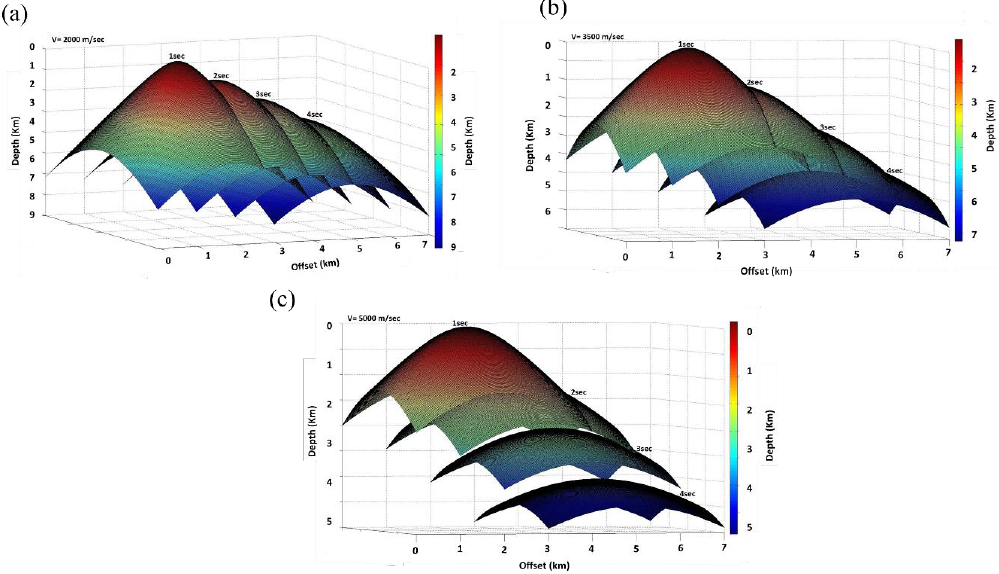
Figure 2. Di ff raction hyperboloids with constant velocity at: ( a ) 2000 m / sec, ( b ) 3500 m / sec, and ( c ) Figure 2. Diffraction hyperboloids with constant velocity at: ( a ) 2000 m/sec, ( b ) 3500 m/sec, and ( c ) 5000 m / sec. The curvature of the hyperboloids is spread out with an increase of 5000 m/sec. The curvature of the hyperboloids is spread out with an increase of velocity.